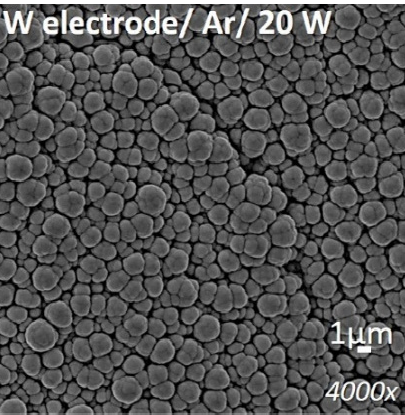
Figure 9. Margin zone_SEM images of W surface electrodes exposed to Ar-MD.